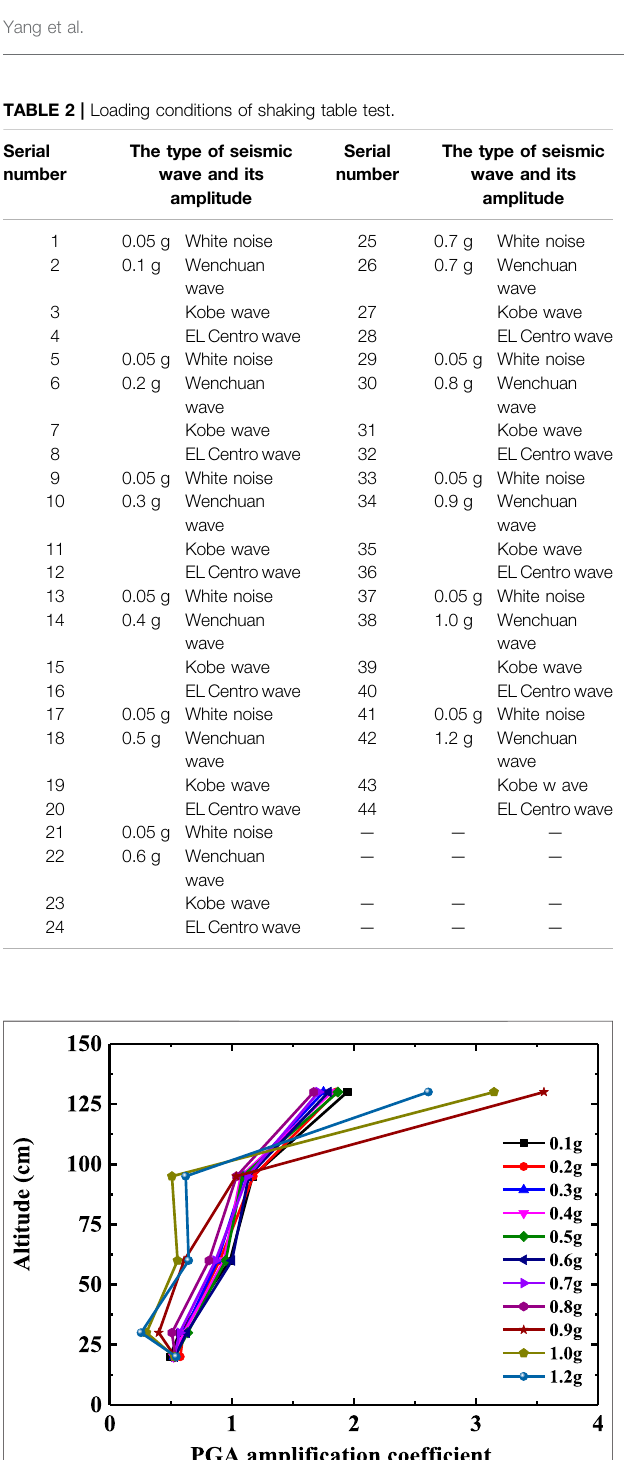
Frontiers in Physics |